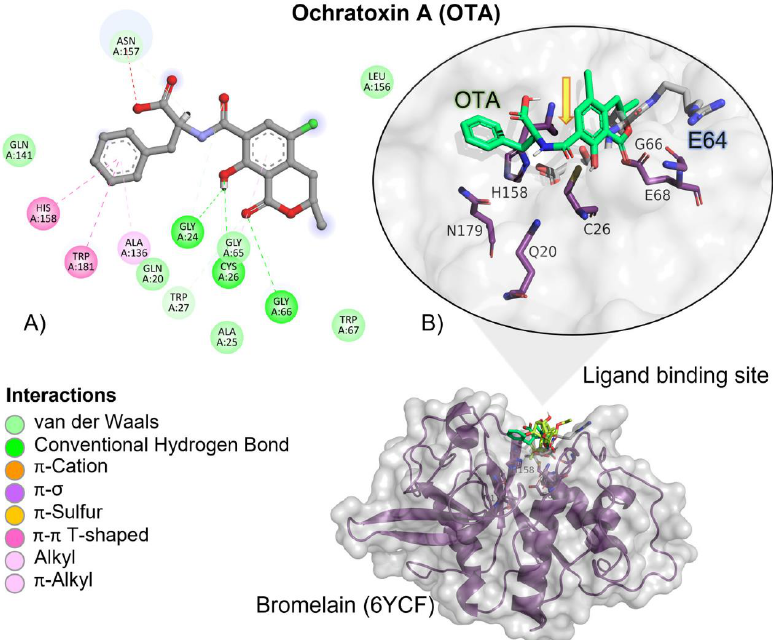
Figure 4. Ochratoxin (OTA) — bromelain interactions. ( A ) Detailed view showing the interactions of the different amino acid residues within the binding pocket of bromelain with the OTA ligand. ( B ) Panoramic view of the reference (E64) and the tested OTA ligands within the binding pocket of bromelain. Comparison between the docked pose of the tested and the reference ligand within the bromelain binding pocket. The yellow arrow indicates the proximity between the bromelain cata- lytic triad and the OTA amide bond, suggesting its breakup. According to docking studies, the inactivation mechanism in OTA by bromelain trig- gers the catalytic action of Cys26 that attacks the carbonyl of the amide group in OTA, resulting in α -ochratoxin and β -phenylalanine as the final products (Figure 5).